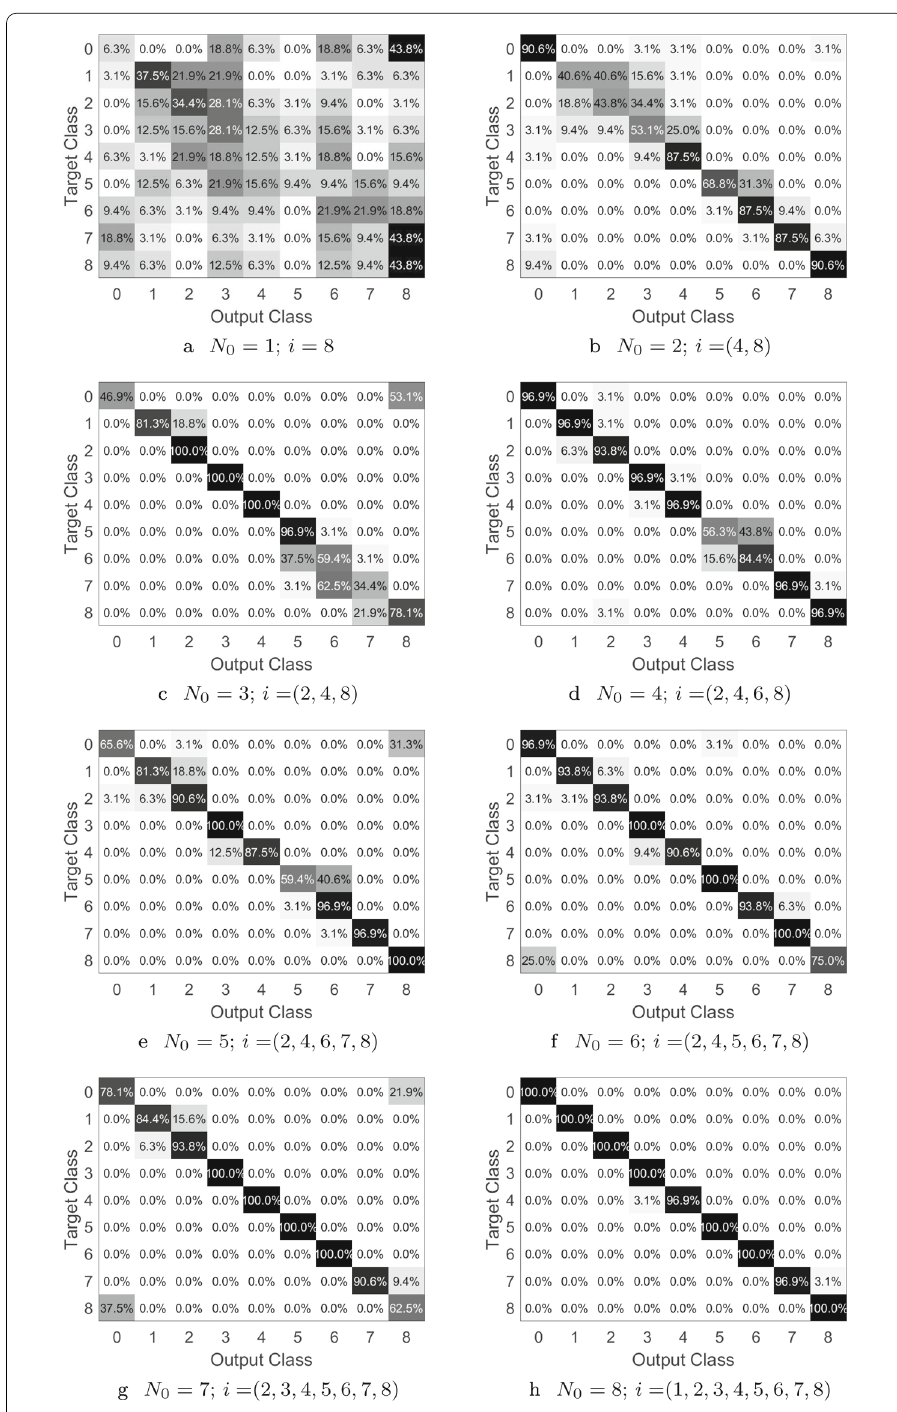
Fig. 17 G l confusion matrices for different number N 0 of input channels F i ∗ . Case 2, f min = 5 and f max = 7